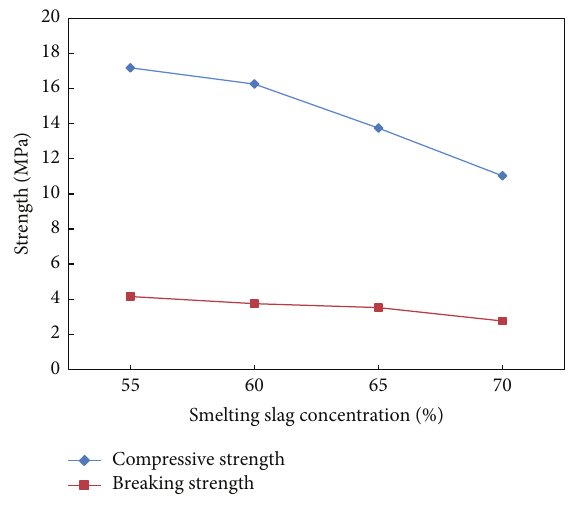
Figure 1: Strength among cementitious materials with various smelting concentration.